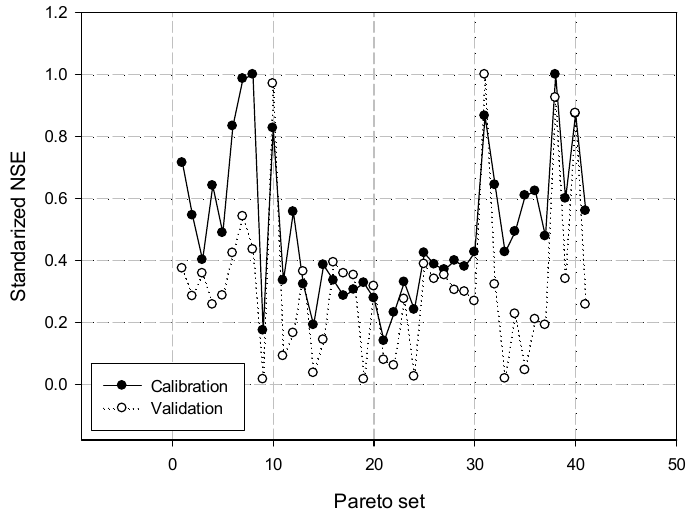
Figure 7. Standardized NSEs from calibration (E1 and E2) and evaluation sets (E3, E4 and E5).